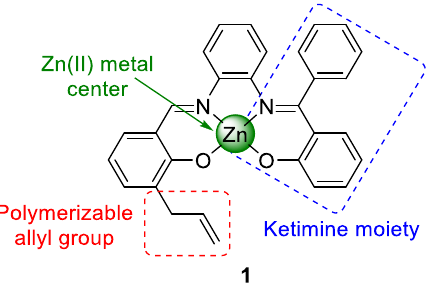
Figure 1. The Zn-Salphen complex 1 , functionalized with a polymerizable allyl group designed, synthesized, and characterized in this